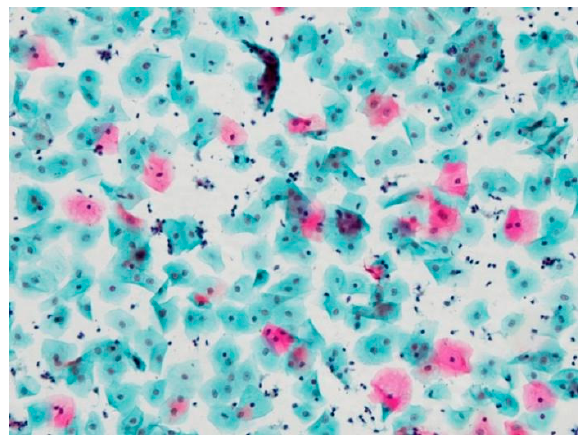
Figure 5. The pseudo-color image.